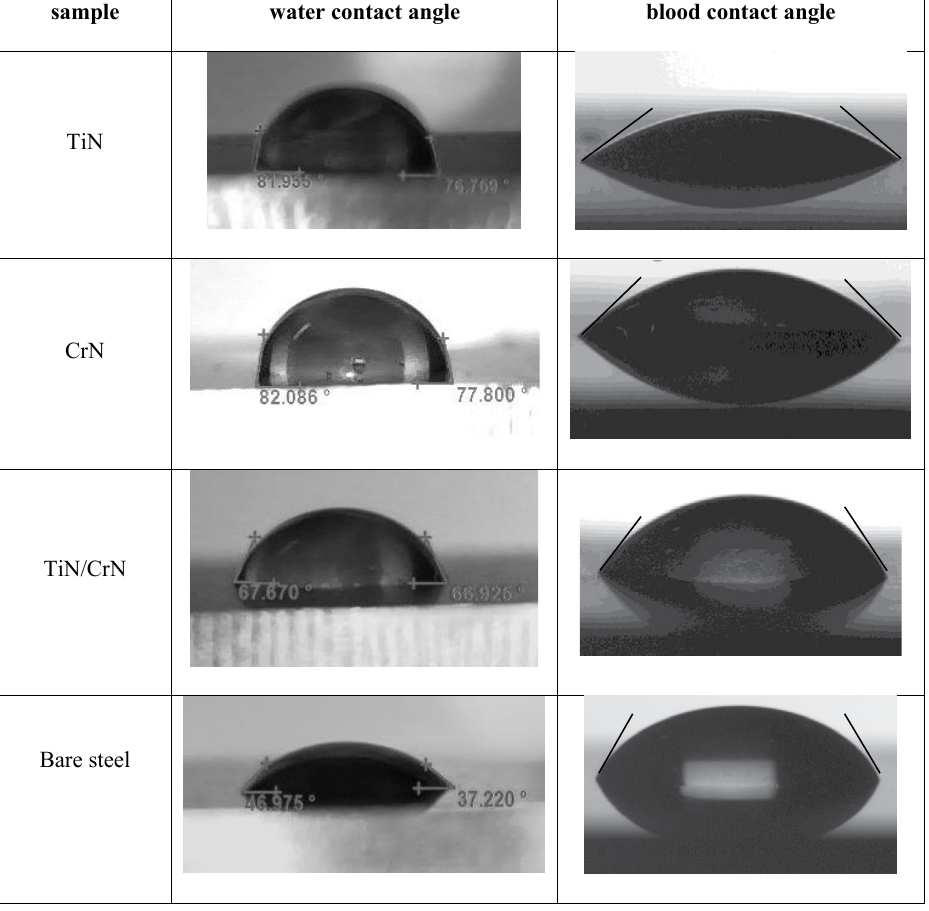
Fig. 7. Water contact angle and blood contact angle measurement images of all